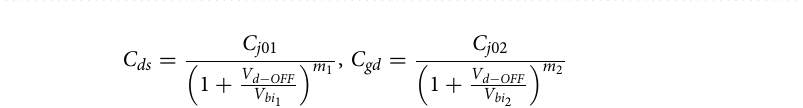
Figure 7. Block diagram of the Presented Analysis for the Class E